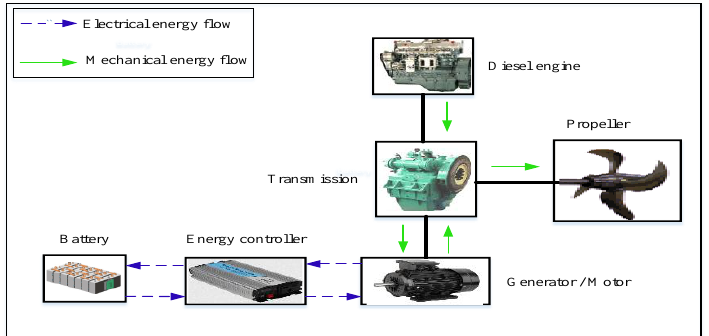
Figure 1. Structure diagram of power system of the tuna longline fishing boat. Table 1. Main parameters.